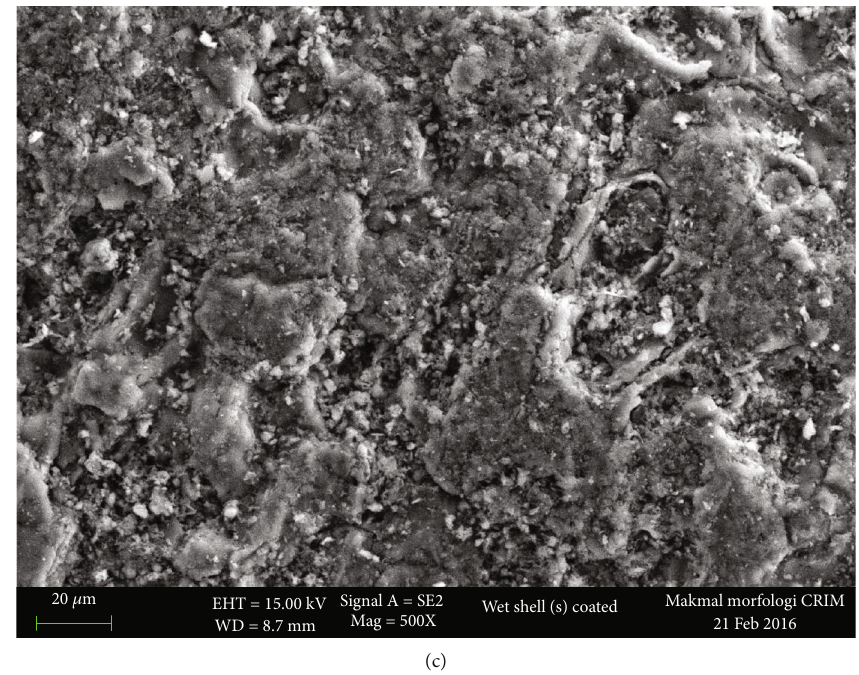
Figure 1: FESEM micrographs of the synthesized P-GSC at the magni fi cations: (a) 100x, (b) 500x, and (c)